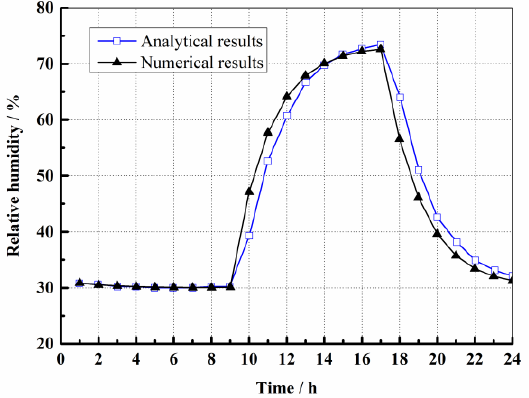
Figure 4. Comparison of simulated RH with analytical results [38].